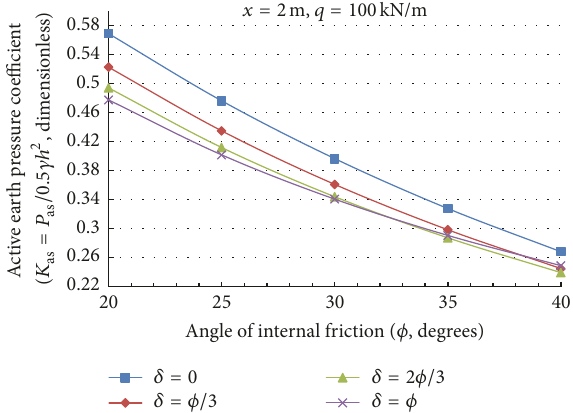
Figure 4: Changes in active pressure coefficient ( 𝐾 changes in the angle of internal soil friction for different amounts of friction angle between soil and wall.